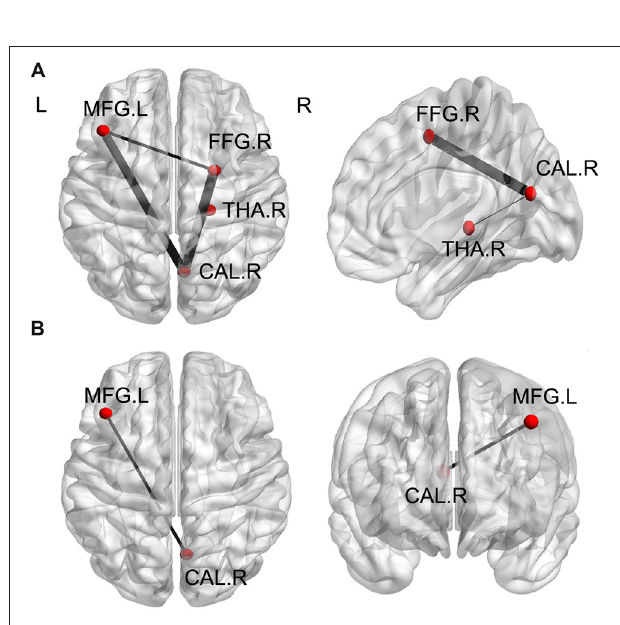
FIGURE 4 | Significant differences of functional connectivity (FC) of ROI regions among the three groups ( p < 0.05, FDR corrected). (A) Compared with healthy controls, the MHE patients showed significantly lower FC between the CAL.R and FFG.R/THA.R, as well as greater FC between the MFG.L and FFG.R/CAL.R. (B) When compared to the NMHE group, greater FC between CAL.R and MFG.L in MHE patients. The threshold was set p < 0.05 with FDR correction. Lines represent FC between each pair of defined ROI regions with significant group differences between two groups. The size of lines represents the absolute value of T values. FFG, fusiform gyrus; THA, thalamus; CAL, calcarine; MFG, middle frontal gyrus; R, Right; L, Left. TABLE 4 | Brain regions with significant group differences on functional